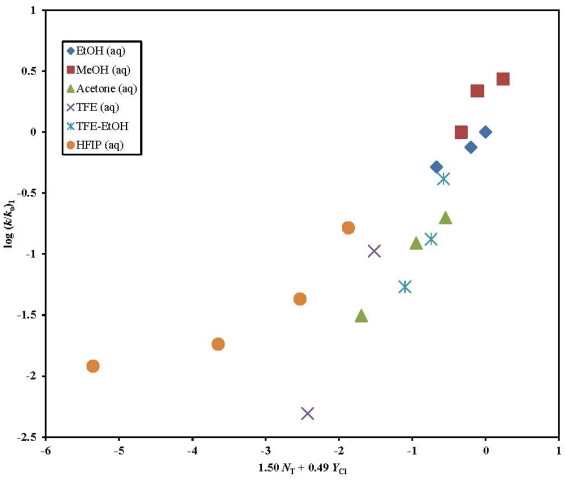
The plot of log (k/ko) for 1 against 1.50 NT + 0.49 YCl.